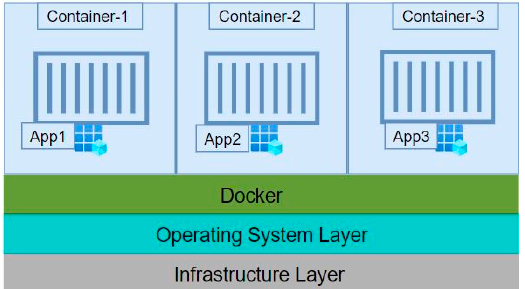
Figure 1. Containerised Application with Docker [2]